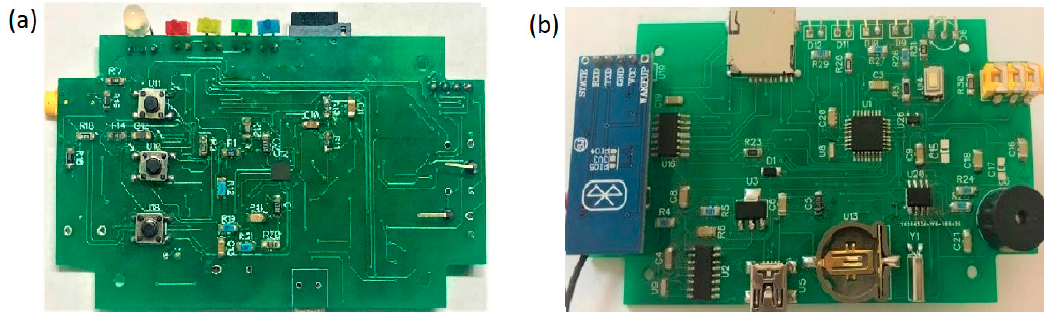
Figure 18. ( a ) Printed circuit board (custom PCB) top view and ( b ) bottom view.